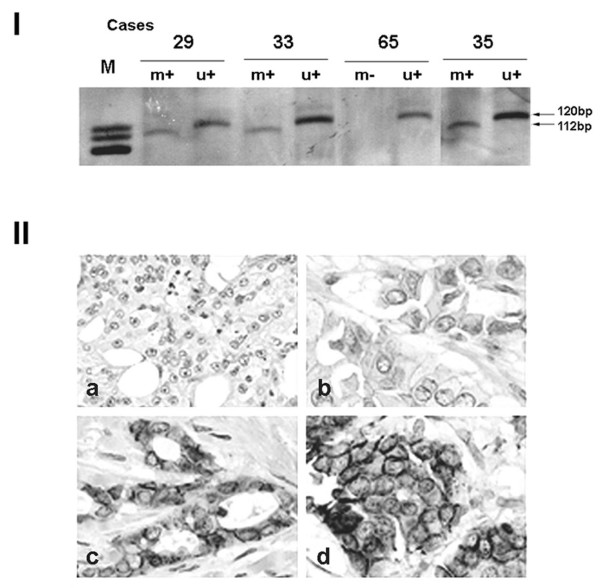
I) Representative examples of MSP for CDH1 gene in infiltrating ductal carcinomas. Lanes (m) and (u) correspond to reactions specific for methylated and unmethylated DNA, respectively. M, molecular weight DNA marker. II) Patterns of E-cadherin expression in ductal breast carcinomas stratified according a four-step scale: a. negative; b. 1+; c. 2+; and d. 3+. The sections were counterstained with hematoxylin. 400× magnification.